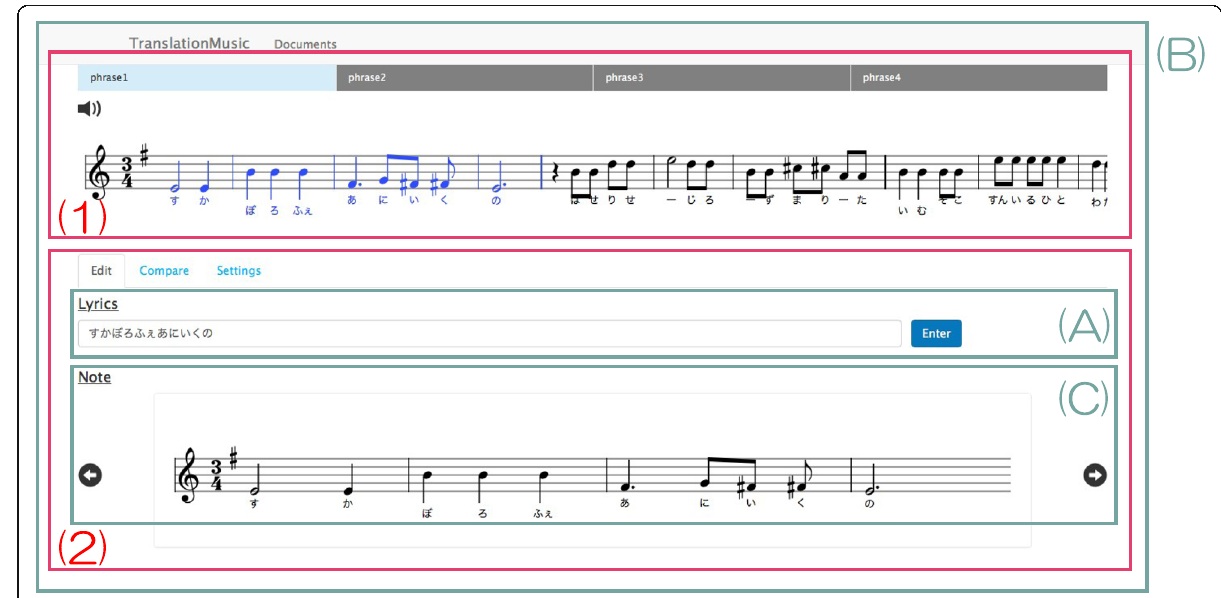
Fig. 3 Screenshot of preliminary